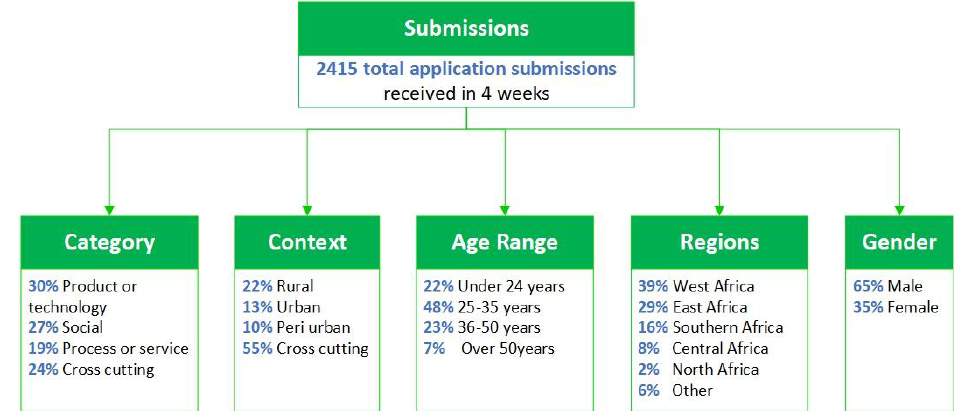
Figure 1. Innovator profiles from the 2018 Innovation Challenge.